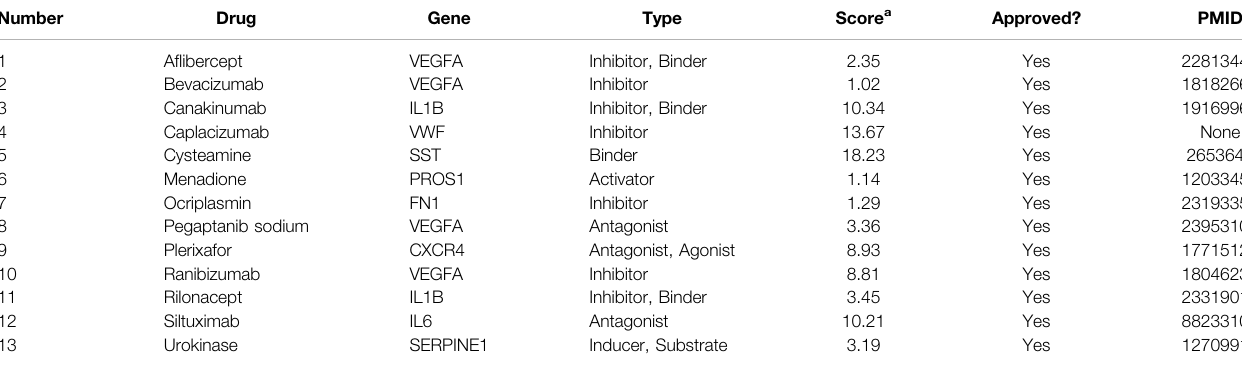
TABLE 1 | Potential drugs targeting genes with SCI and AS association.